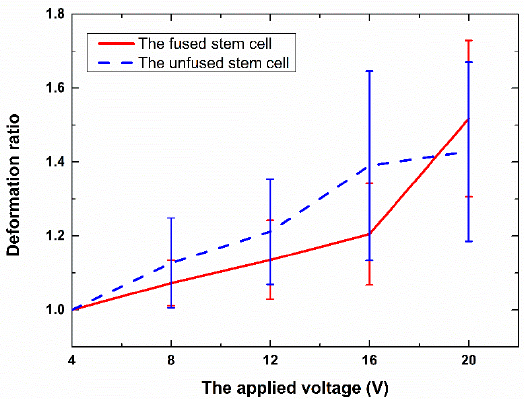
Figure 5. The deformation ratio vs. the applied voltage for the fused and unfused stem cells.